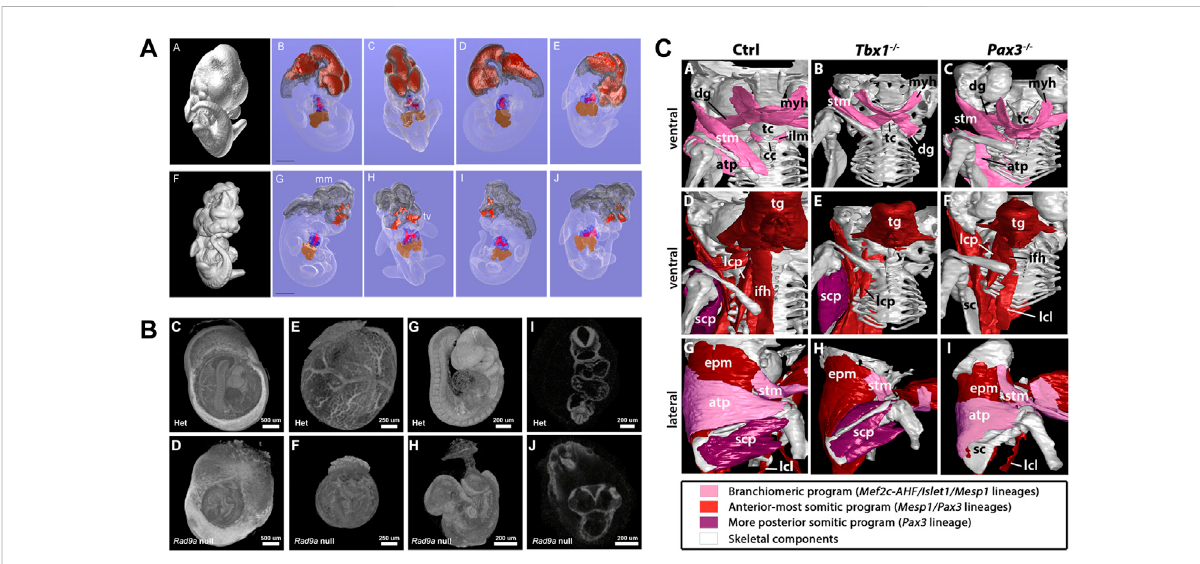
FIGURE 5 MicroCT for qualitative analysis of mutant mouse embryos. (A) MicroCT data used for isosurface and segmentation renderings to facilitate comparison of wildtype (top) and Pax3:Fkhr oncogene expressing (bottom) E11.5 mouse embryos [Figures 4A – J from Johnson et al., 2006, PLoS Genetics 2 (4)]. (B) Volume renderings of heterozygous and embryonically lethal Rad9a null mice at E9.5. Embryos imaged within yolk sacs and digitally segmented out from the original data set to assess early and subtle structural alterations unaffected by preparation artefacts (Figures 4C – J from Hsu et al., 2016, Developmental Biology 419 (2)). (C) Segmentation and surface renderings allow depiction of musculoskeletal malformations in Tbx1 and Pax3 mutants (Figure 6 from Heude et al., 2018, eLife 7). All images reprinted under the terms of the Creative Commons Attribution